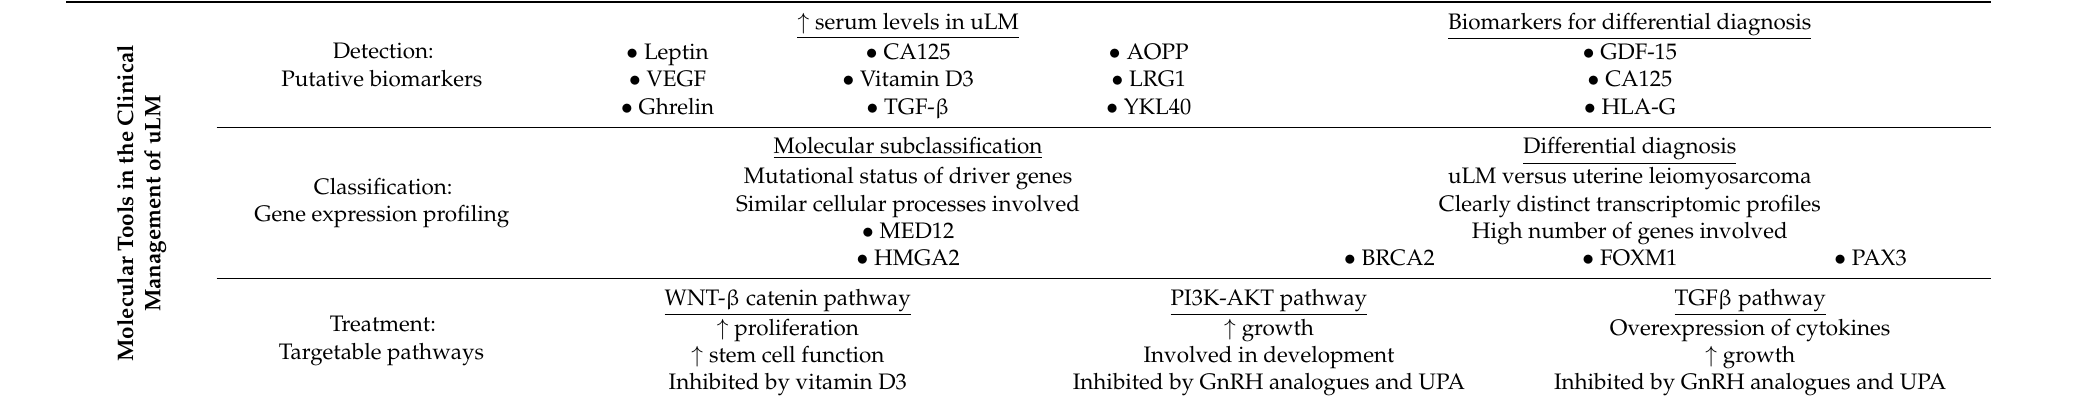
Table 1. Molecular tools in clinical management of uterine leiomyomas. Possible applications include discovery of biomarkers for detection, classification based on gene expression profiling or pathway-targeting for